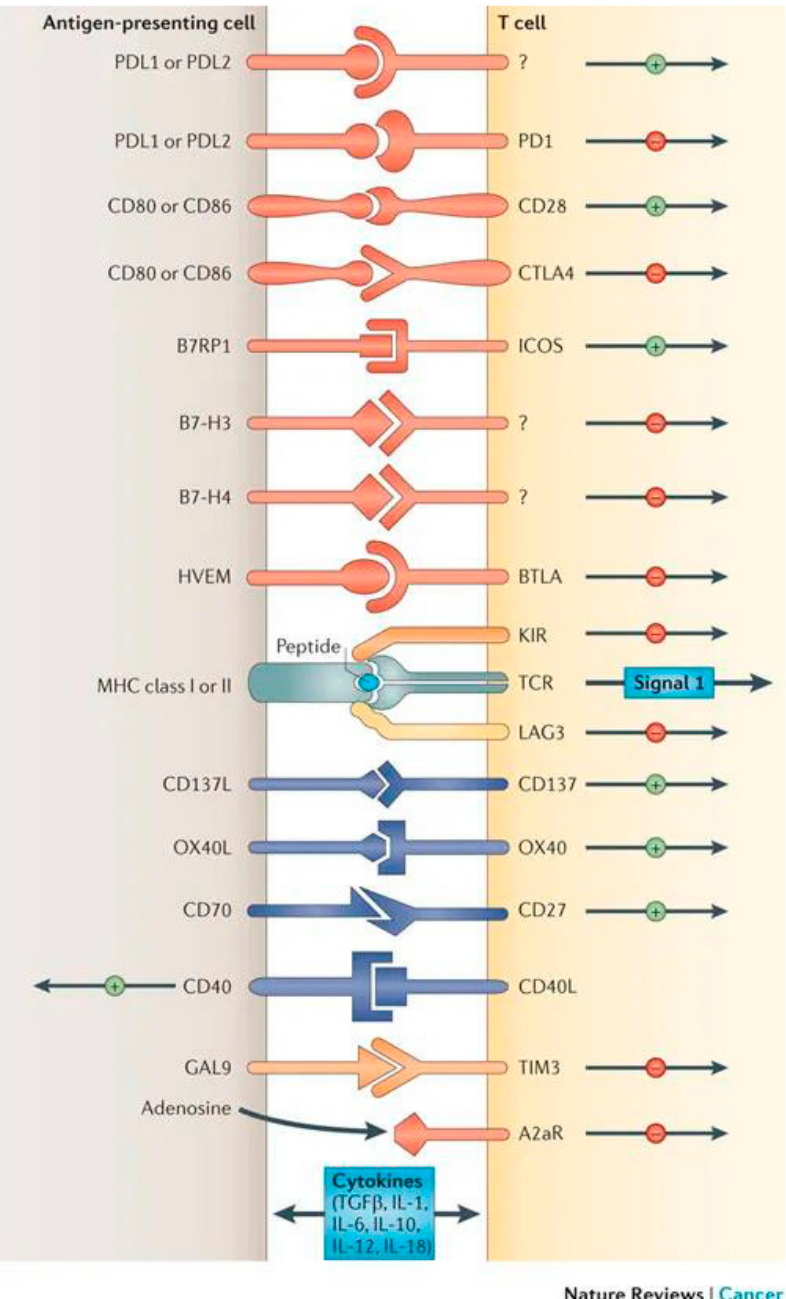
Figure 1. Overview of receptor-ligand interactions involved in checkpoint modulation. Description: Examples of different receptors and ligands involved in checkpoint modulation, along with generalized stimulatory (+) or inhibitory ( − ) effects. Reprinted with permission from: Spinger Nature: Pardoll, D.M. The blockade of immune checkpoints in cancer immunotherapy. Nat. Cancer Rev. 2012 , 12 , 252–264 .